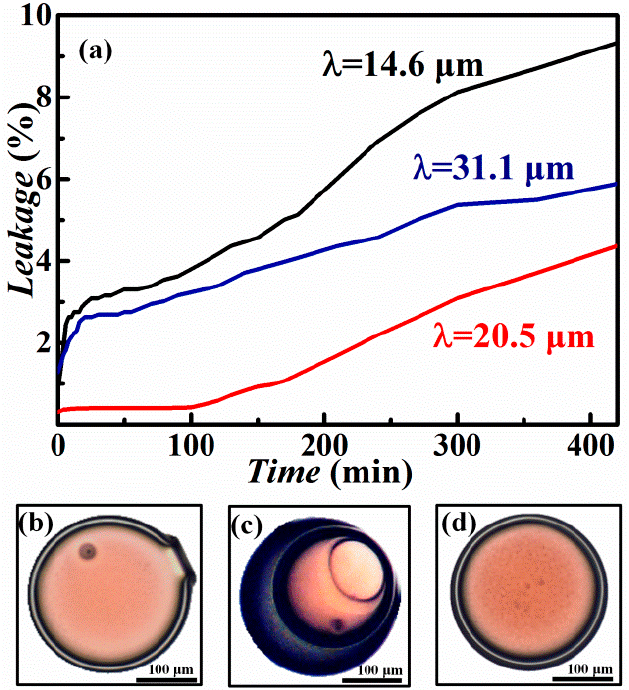
Figure 5. ( a ) Release profile of oxalic acid from microcapsules with different shell thicknesses of 14.6, 20.5, and 31.1 µ m. ( b ) Microscopy image of a prematurely ruptured microcapsule with λ = 14.6 µ m (thin shell). ( c ) Microscopy image of a microcapsule with λ = 31.1 µ m (asymmetric shell thickness). ( d ) Microscopy image of a microcapsule with λ = 20.5 µ m (uniformly distributed shell thickness).